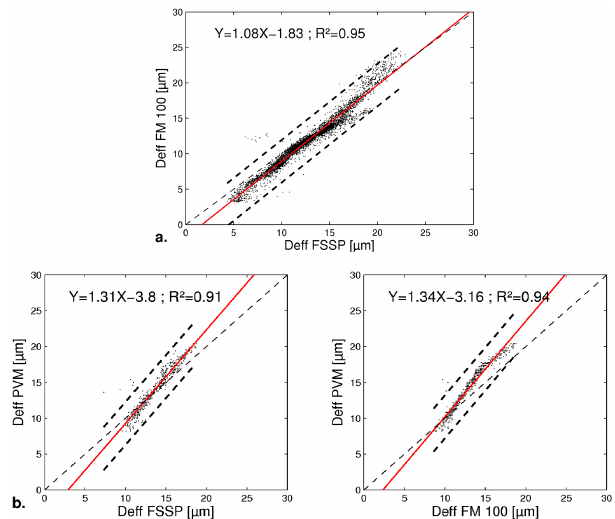
Figure 4. (a) Comparison between the 1min averaged effective di- ameters of the FM-100 and the FSSP. (b) Comparison between the 5min averaged effective diameters between the PVM and the FSSP (left) and with the FM-100 (right). The bold dashed lines show the instrumental errors applied to the fit.